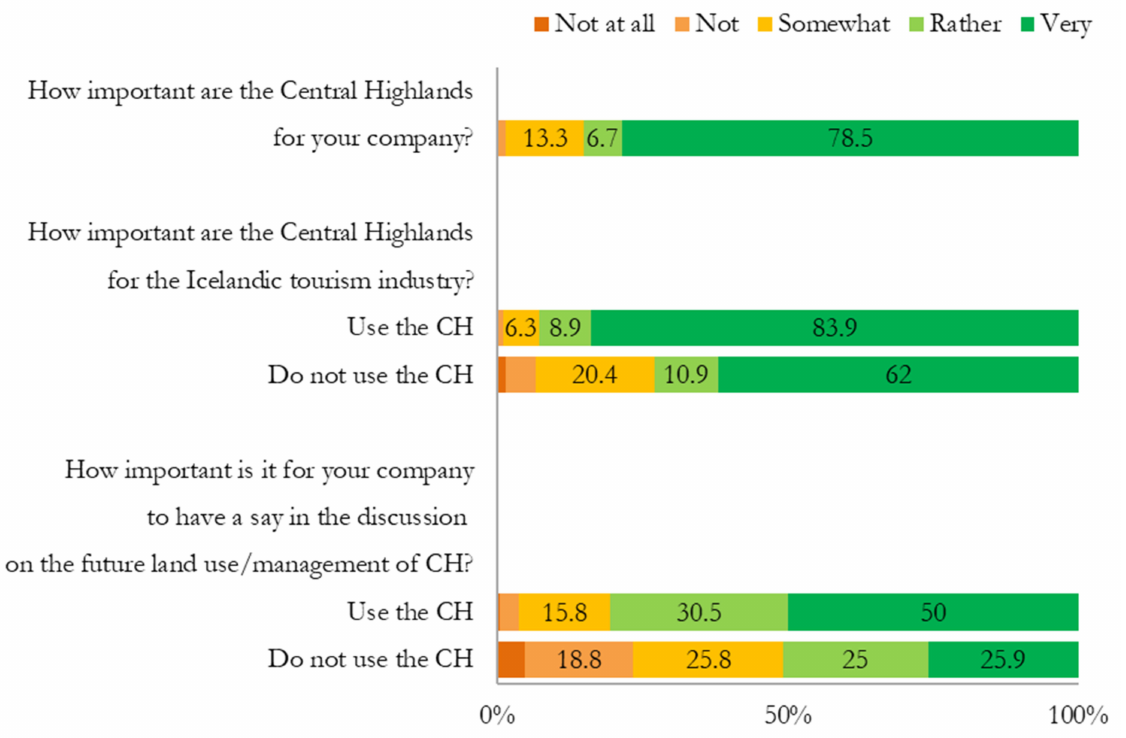
Figure 4. The importance of the Icelandic Central Highlands as evaluated by the tourism